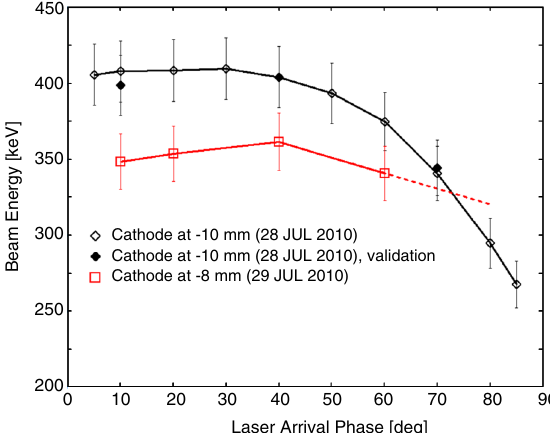
FIG. 18. Beam energy as a function of laser timing, for two cathode locations. Error bars calculated as discussed in the caption for Fig.